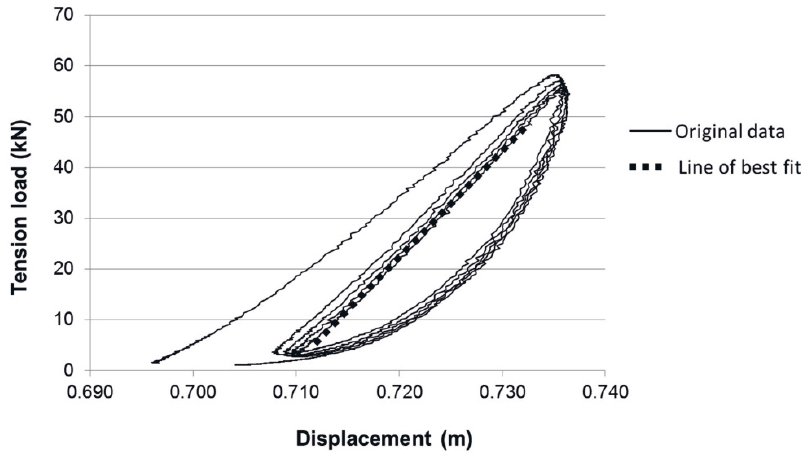
Figure 8. P1-3 eye splice extension during test